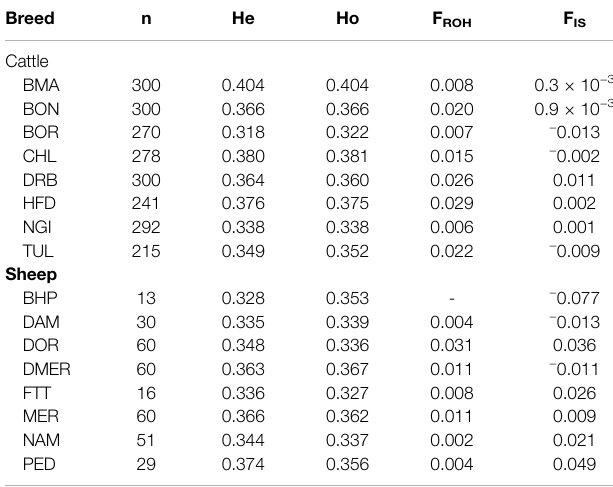
TABLE 1 | Summary statistics of the genetic diversity and inbreeding coef fi cients within several cattle and sheep populations occurring in South Africa. Breed n He Ho F ROH F IS Cattle